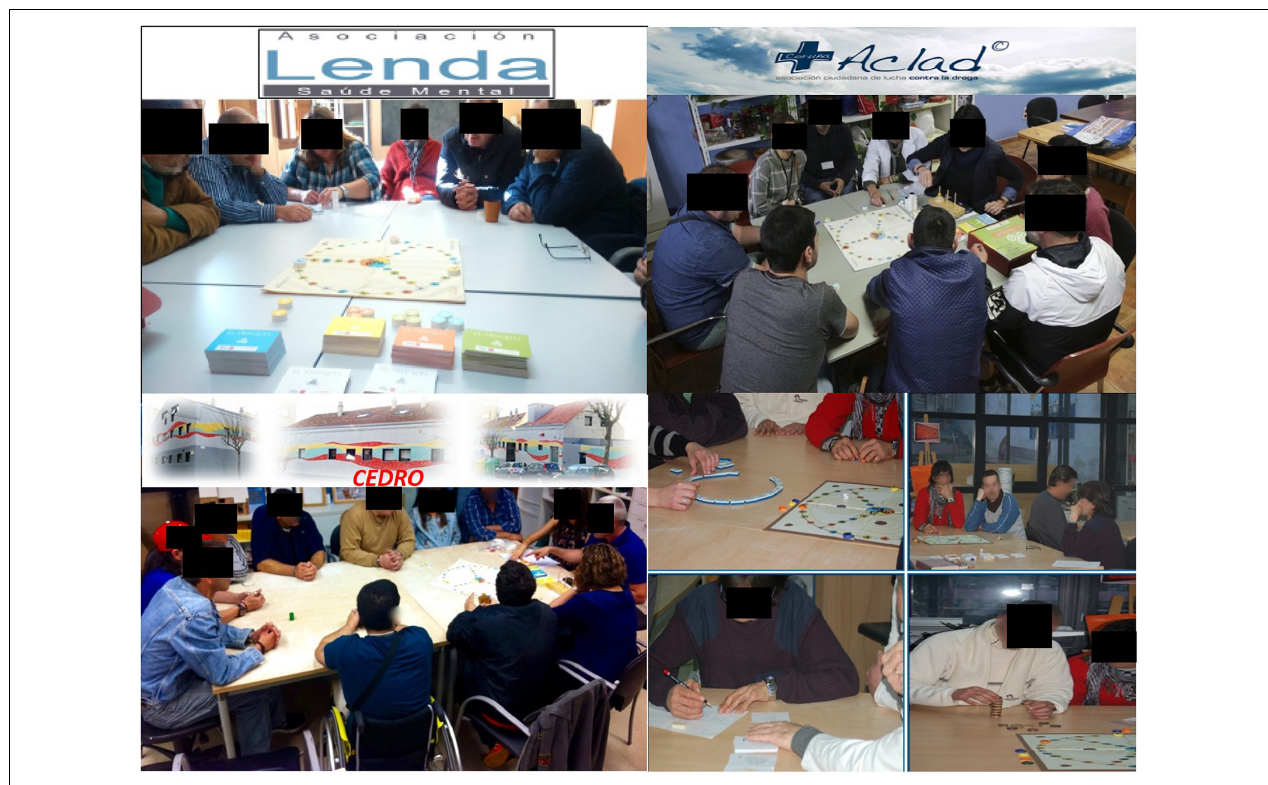
FIGURE 2 | Pictures of Trisquel sessions in different rehabilitation